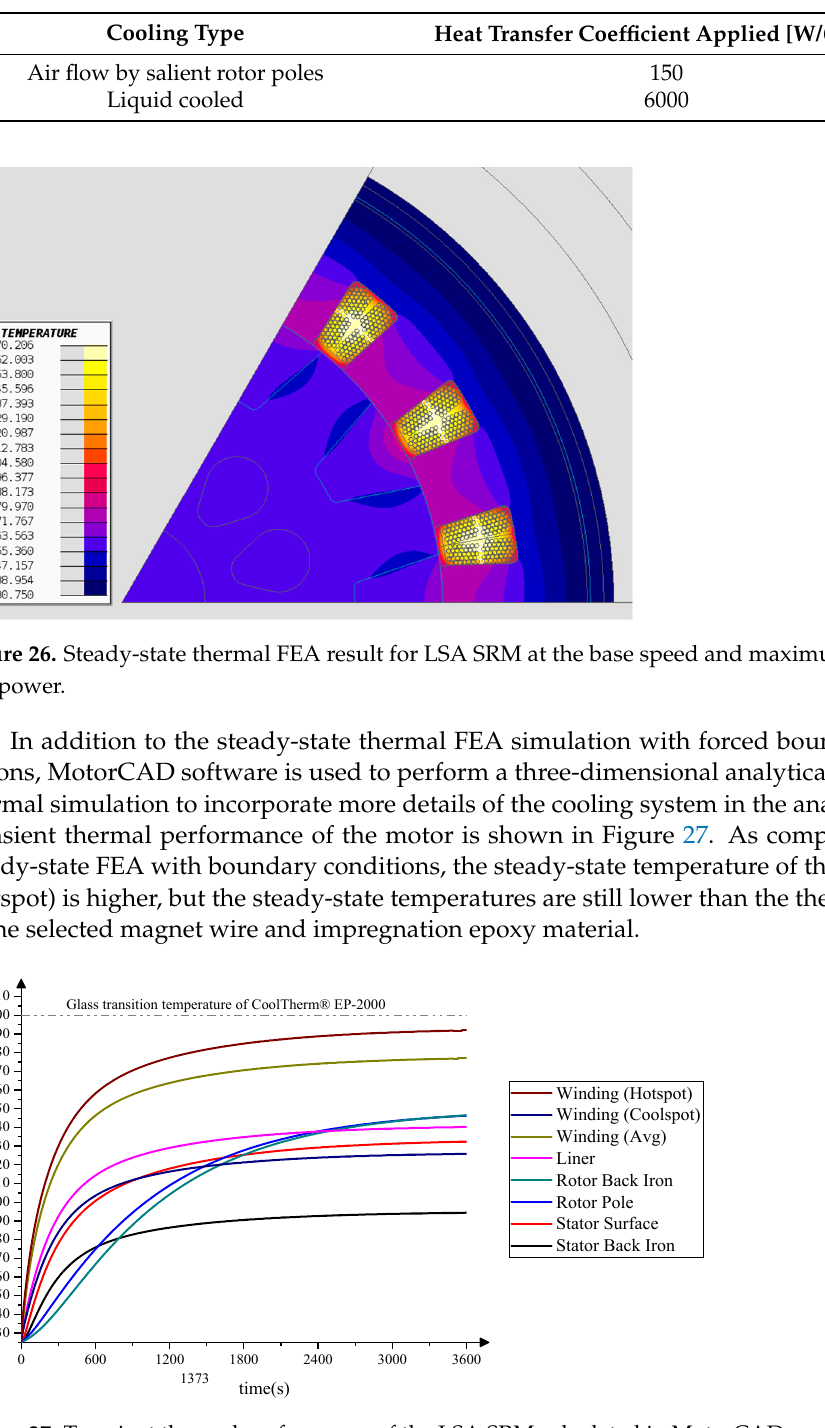
Figure 27. Transient thermal performance of the LSA SRM calculated in MotorCAD.